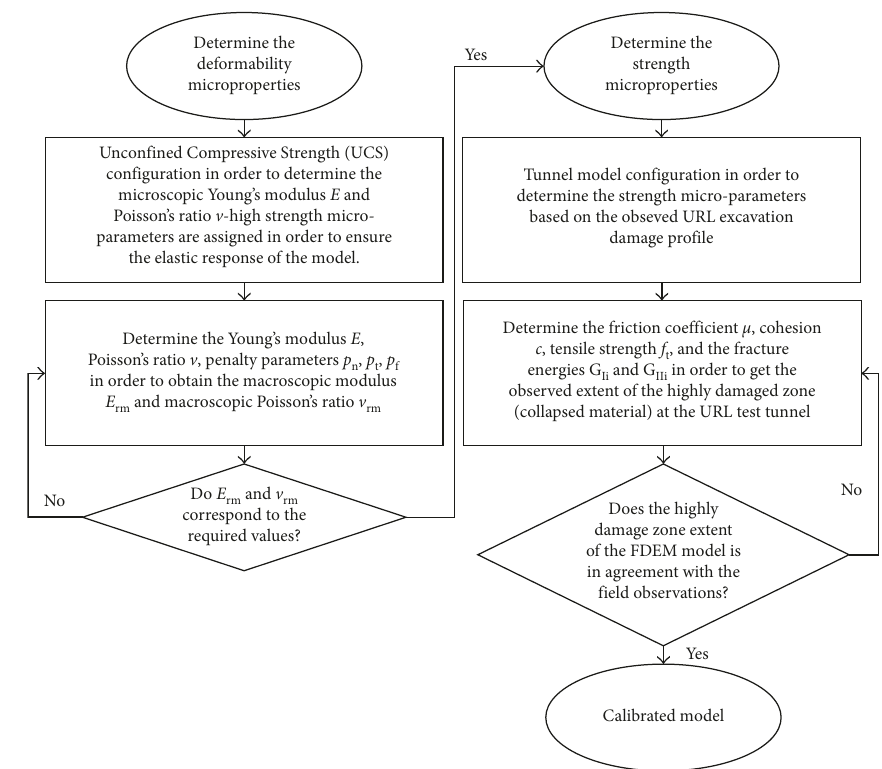
Figure 6: Calibration process employed for determining the required input parameters in the FDEM model. The microscopic Young’s modulus E and Poisson’s ratio ] refer to the elastic constants of the triangular elements ( E and ] at element scale). The macroscopic values refer to the Young’s modulus and Poisson’s ratio obtained from the UCS testing in Figures 2 and 3 ( E rm and ] rm at 7.5m height specimen scale). For more information, the reader is referred to